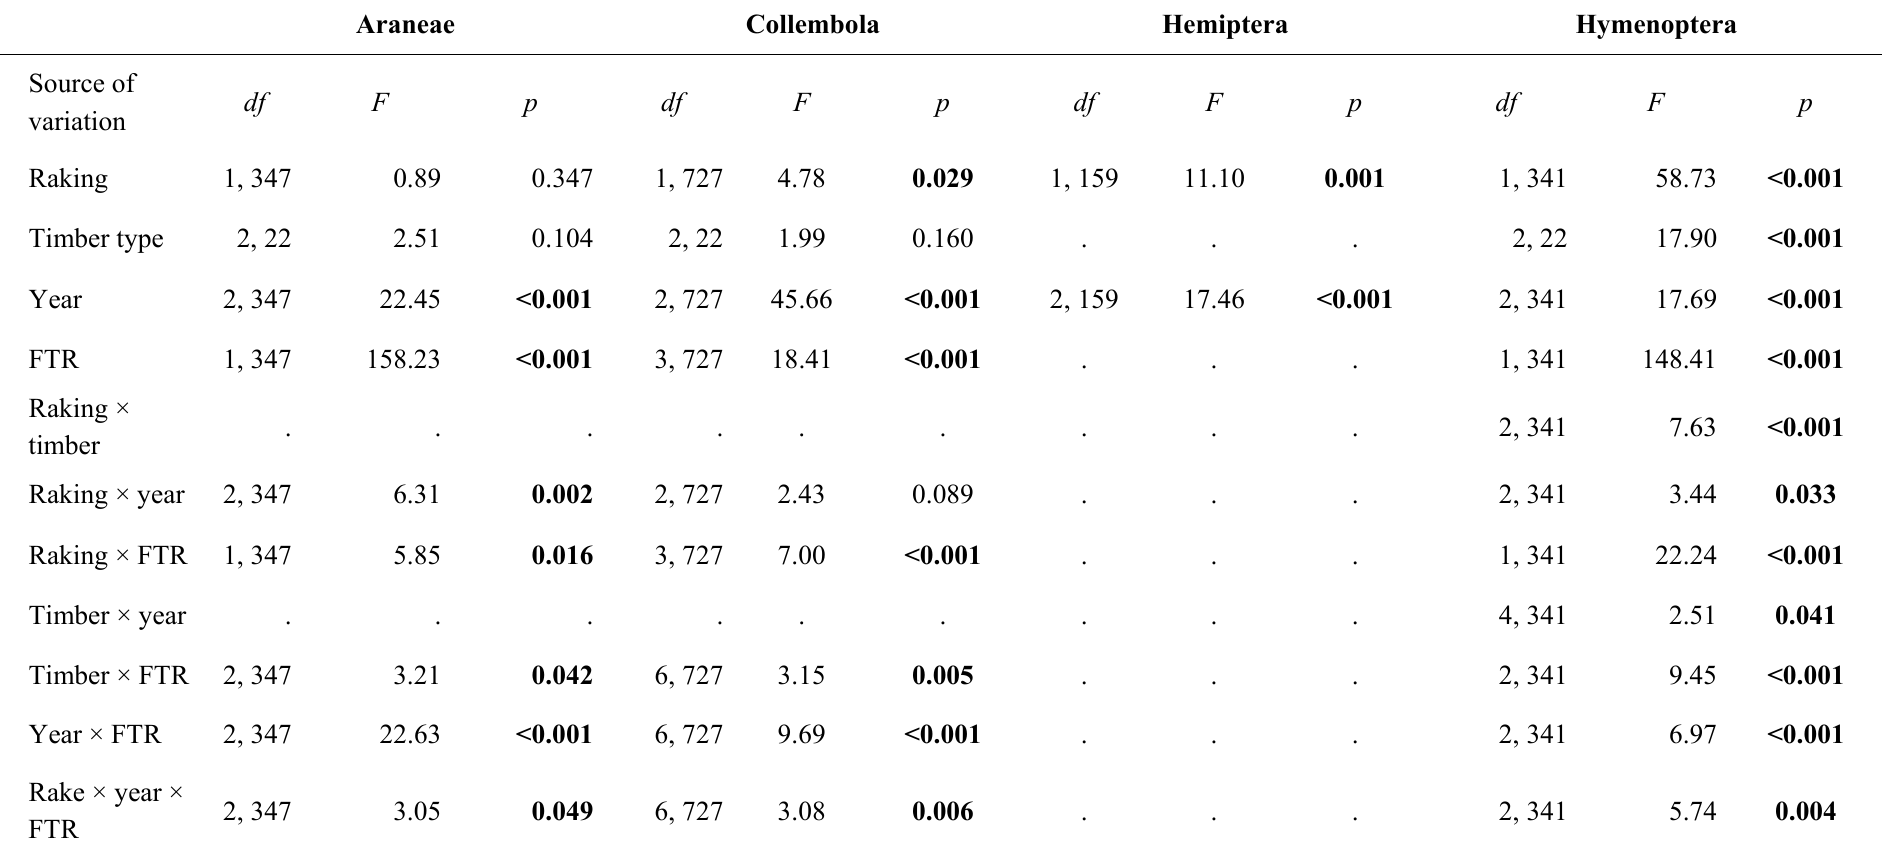
Table 1. ANOVA table for the most parsimonious model explaining the effects of pine straw raking on terrestrial arthropod abundance based on significant log-likelihood ratio tests (LLRT < 0.05); fixed effects (the source of variation), degrees of freedom ( df ), F -ratio ( F ), and significance levels for the main effects and interactions including raking (pine straw intact or raked), timber type (loblolly, slash or longleaf pine), year (2008, 2009, or 2010), and finer taxonomic resolution (FTR); significant effects are in